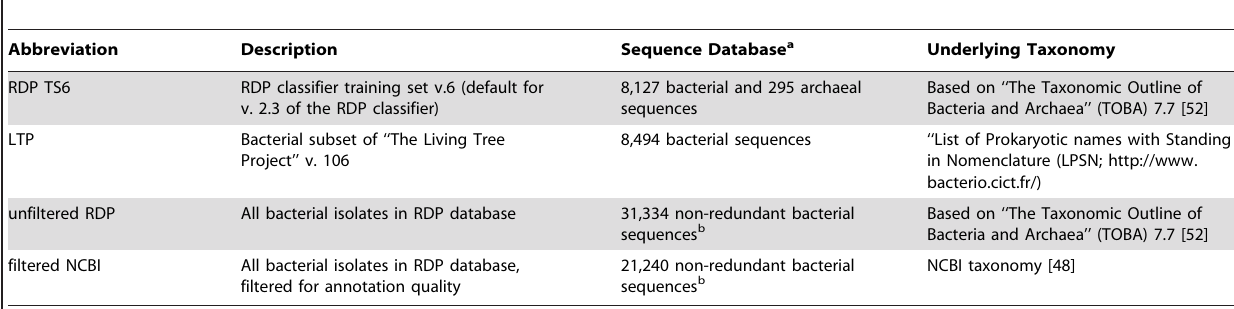
Table 1. Training sets used for the naı¨ve Bayesian classification of bacterial 16S rRNA gene